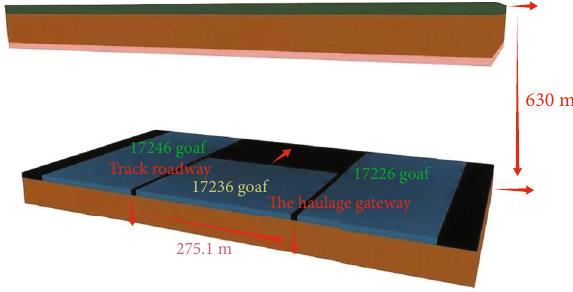
Figure 2: Schematic diagram of position relationship of 17236 working-face.